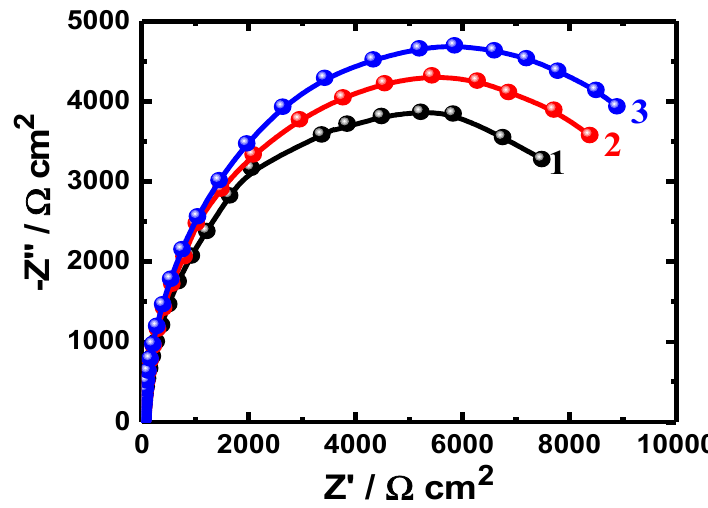
Figure 1. Nyquist plots obtained for (1) PS, (2) PSC1, and (3) PSC2 after their immersion in 4% NaCl solution for 1.0 h.